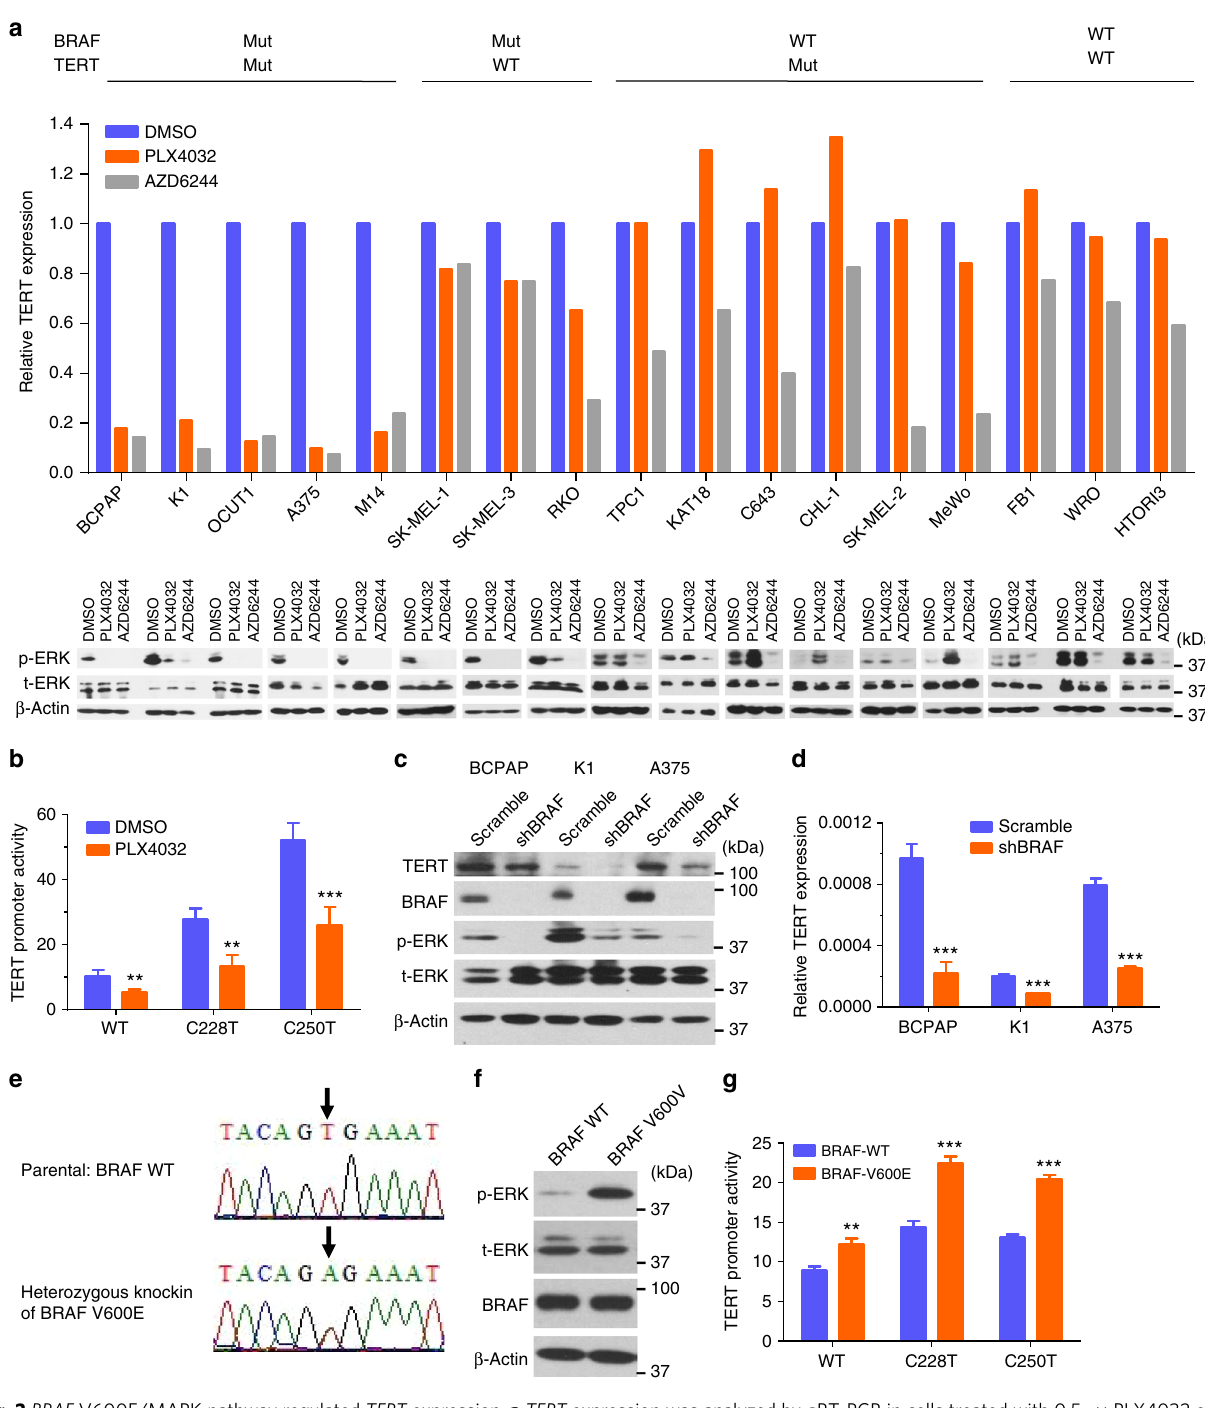
Fig. 2 BRAF V600E/MAPK pathway regulated TERT expression. a TERT expression was analyzed by qRT-PCR in cells treated with 0.5 μ M PLX4032 or 0.2 μ M AZD6244 for 24 h (upper panel). The corresponding levels of phosphorylated ERK (p-ERK), total ERK (t-ERK), and beta-actin were detected by western blotting (lower panel). The relative TERT mRNA expression levels were normalized to the DMSO control group. b Luciferase reporting assay of TERT promoter activities in K1 cells treated with DMSO or PLX4032 (0.5 μ M ). c , d Speci fi c shRNA against BRAF were used to knock down BRAF in thyroid cancer cell lines BCPAP and K1 and melanoma cell line A375. Scramble shRNA was used as control. Cells were then subjected to western blotting ( c ) and qRT- PCR ( d ). e Sequencing of the BRAF exon-15 in the parental and heterozygous BRAF -V600E knock-in SW48 cells. BRAF V600E was knocked in on one allele of BRAF by rAAV technology through homologous recombination and Cre recombinase of the Neo cassette. f Western blotting analyses of phosphorylation of ERK (p-ERK), total ERK (t-ERK), BRAF, and beta-actin in the parental and BRAF-V600E knock-in SW48 cells. g TERT promoter luciferase reporter assay in SW48 cells with/without BRAF V600E knock-in. ** P < 0.01, *** P < 0.001, by two-tailed Student ’ s t test. P values are for the comparison of the indicated condition with DMSO (panel b ), scramble (panel d ), or BRAF-WT groups (panel g ). All the values represent the average ± standard deviation (SD) of triplicate samples from a typical experiment. All the experiments were performed three times with similar